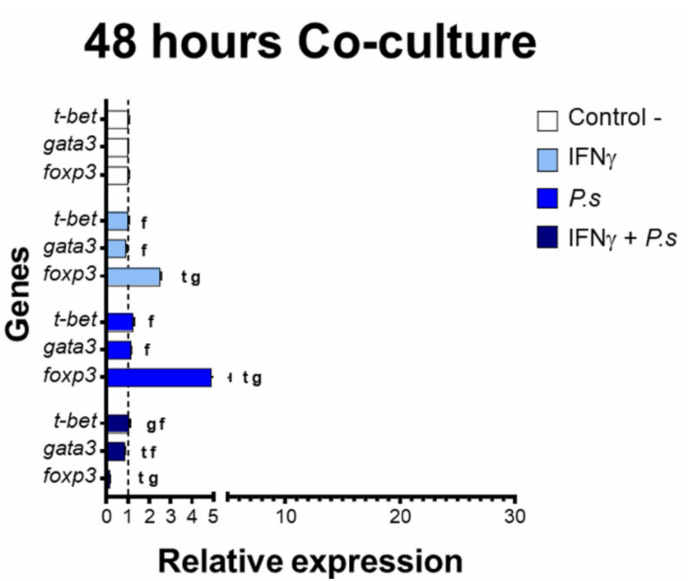
Figure 5. Gene expression presented as fold change relative to controlling T cell transcriptional factors in co-cultures of CD4 + IgM − cells and mononuclear splenocytes MHC + CD83 + , that include MHC − CD83 − cells at 48 h. In white—control without induction (C-). In light blue—co-culture of splenocytes with prior induction with IFN γ . In blue—co-culture of splenocytes with prior induction of P. salmonis ( P.s ). In dark blue—co-culture of splenocytes induced with IFN γ + P. salmonis (IFN γ + P.s ). Each bar: n = 3 fish. Lowercase letters (t, g, and f)—significant differences ( p < 0.05) compared with t-bet , gata3 , and foxp3 , respectively.